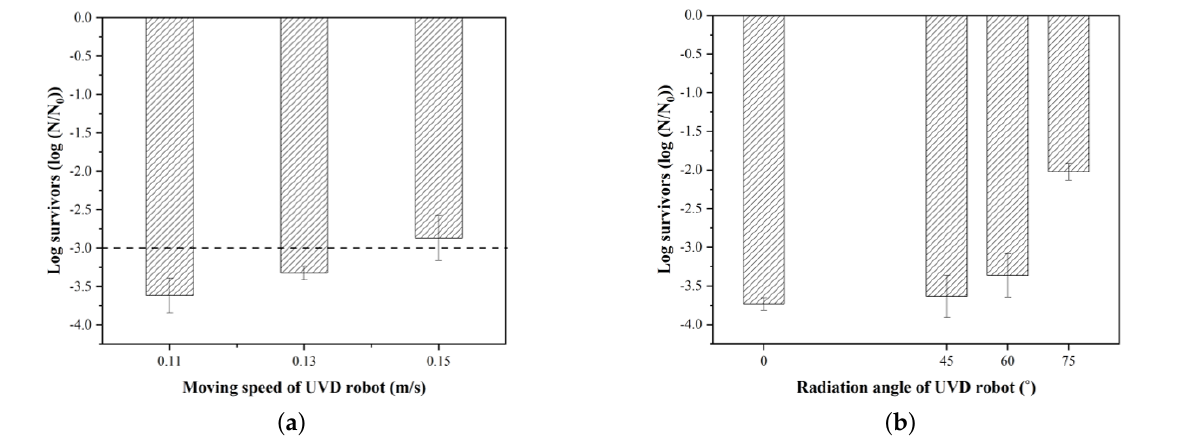
Figure 6. UV-C sterilization effect (log survivor) results to determine the 3-log reduction of bacteria; ( a ) varying the moving speed of the UVD robot; ( b ) the radiation angle of the UVD robot.